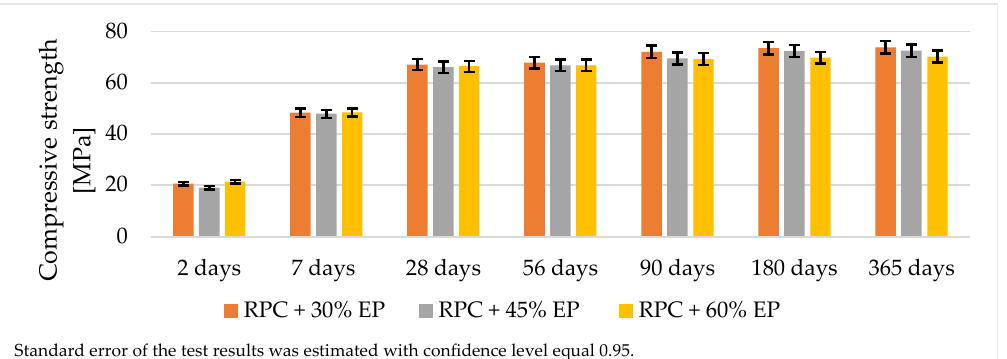
Standard error of the test results was estimated with confidence level equal 0.95. Figure 7. Compressive strength of lightweight RPC containing EP in quantity 30%, 45%, and 60% by volume.